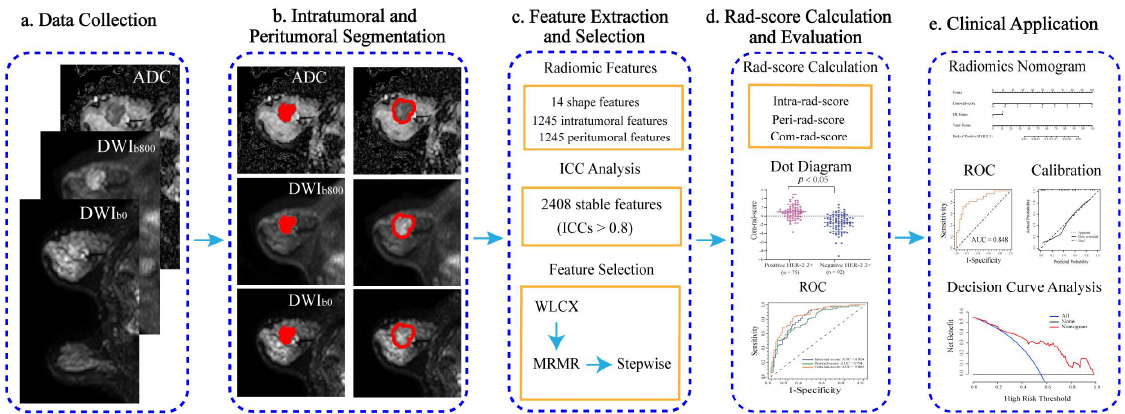
Figure 1. Flowchart of this study. ( a ) Image data (DWI b=0 , DWI b=800 , and ADC) was collected. ( b ) Intra- and peritumoral regions (red masks) were obtained using semi-automatic segmentation. ( c ) A total of 2504 radiomic features were extracted from three images, and ICC analysis and three-step feature selection were performed. ( d ) Three rad-scores were calculated with the selected features using the logistic regression model and evaluated. ( e ) Independent parameters were selected among clinical factors and combined rad-score (com-rad-score) using multivariate logistic analysis and used to establish a radiomics nomogram. ICC, intraclass correlation coefficient; WLCX, Wilcoxon rank-sum test; MRMR, minimum redundancy maximum relevance; ROC, receiver operating characteristic.